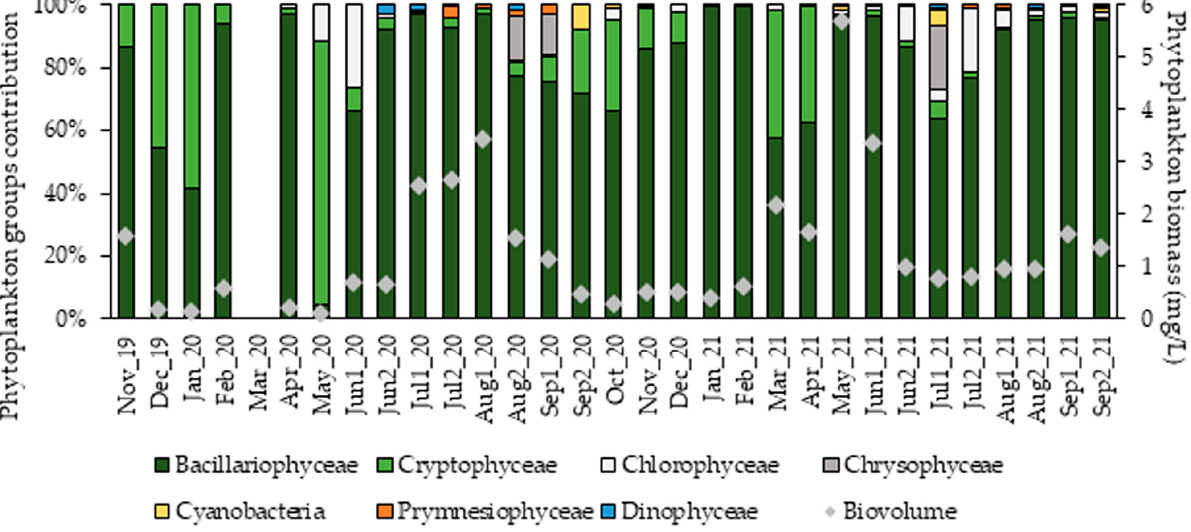
Figure 7. Total phytoplankton biomass (mg/L) in the Moglicë Reservoir during November 2019– September